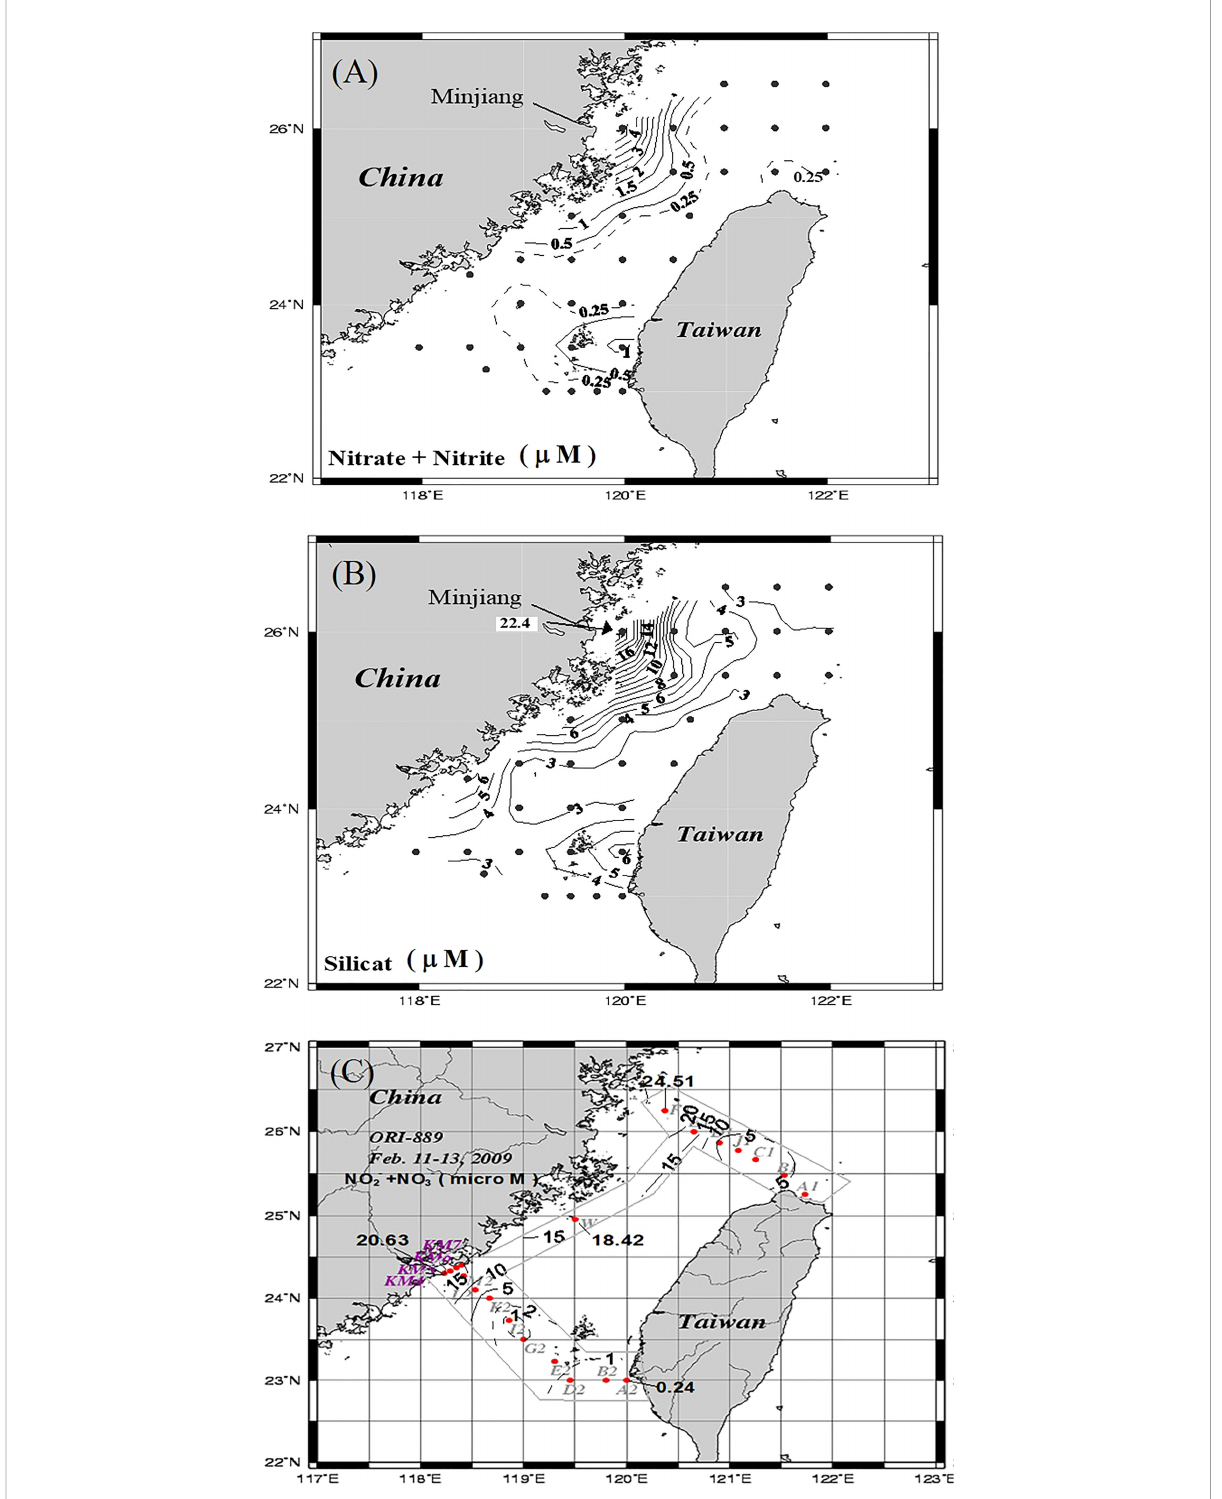
FIGURE 4 Spatial distributions of N+N (A) and silicate (B) concentrations in surface waters of the TS in early summer (CR1353), and of N+N concentrations in surface waters in winter [(C) CR889]. The concentrations of N+N and sampling stations in winter (C) were given with black and gray color,